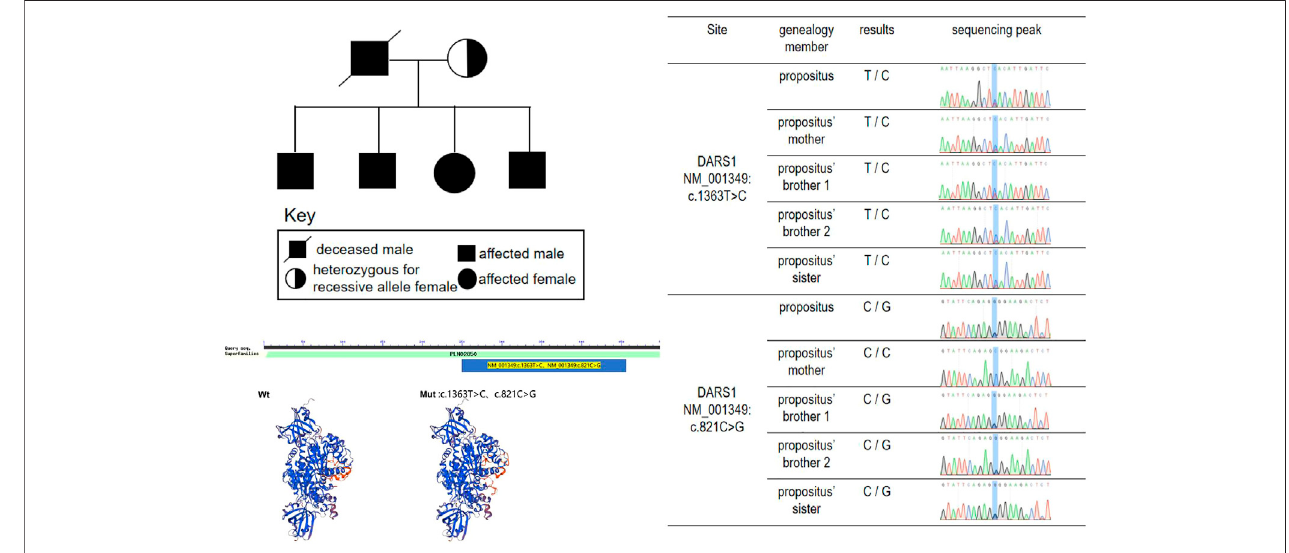
FIGURE 2 | The genetic mutation and genetic lineage map.